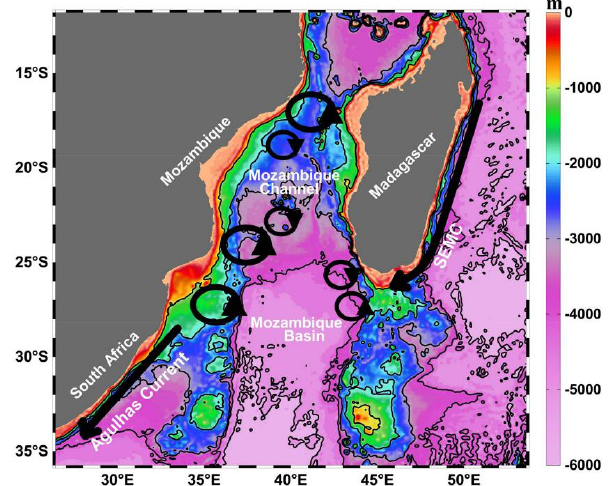
Figure 1. Main oceanographic features in the Mozambique Channel and Mozambique Basin. The southern branch of the East Madagascar Current (SEMC), the Agulhas Current, Mozambique Channel eddies, as well as dipoles stemming from the SEMC are indicated. Anticlockwise (clockwise) circulation features indicate anticyclonic (cyclonic) eddies. Black contours indicate the 1000 m, 2000 m, 3000 m, 4000 m, and 5000 m bathymetric contours.